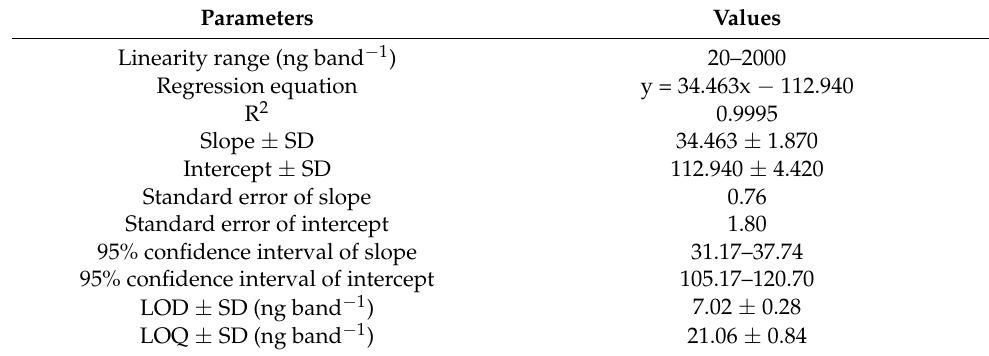
Table 1. Results for the regression analysis for the quantitative analysis of hesperidin (HSP) using a sustainable “reversed-phase high-performance thin-layer chromatography (RP-HPTLC)” method (mean ± SD; n = 6).